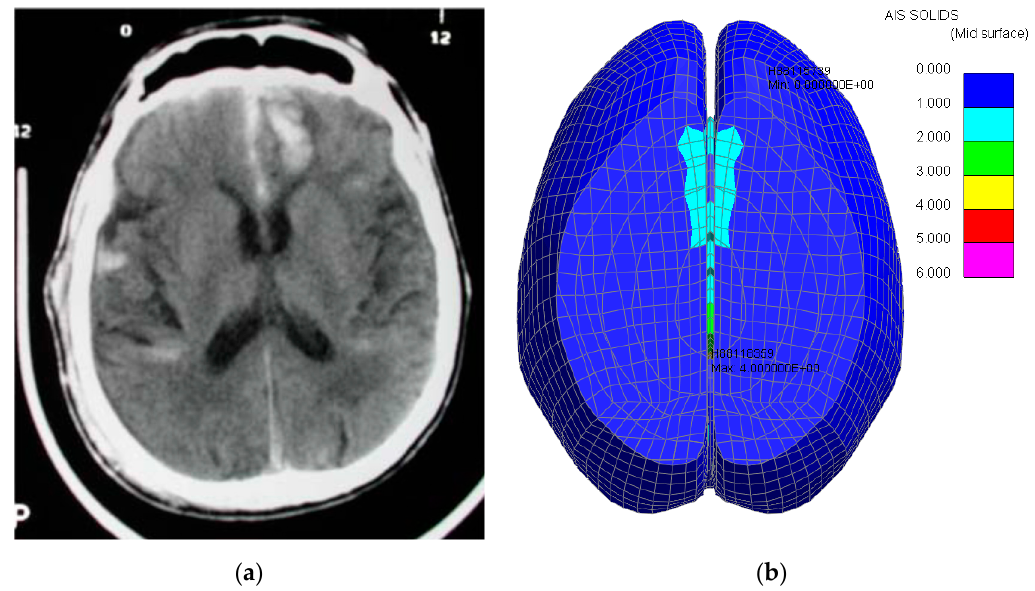
Figure 15. First accident. Brain trauma (contre-coup). Comparison between CT scan [16] ( a ) CT Scan